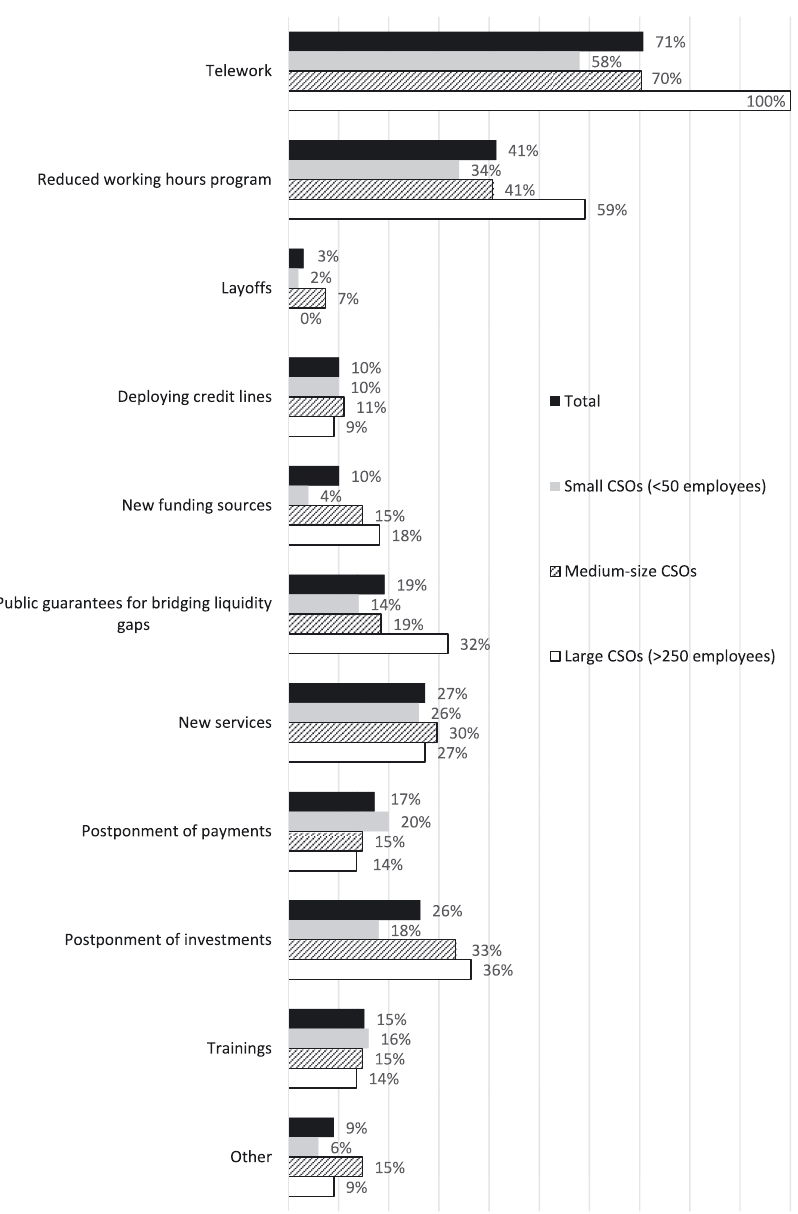
Figure 3: CSOs ’ reactions to financial stress, according to organizational size (n = 99). (Source: Millner et al. 2020,